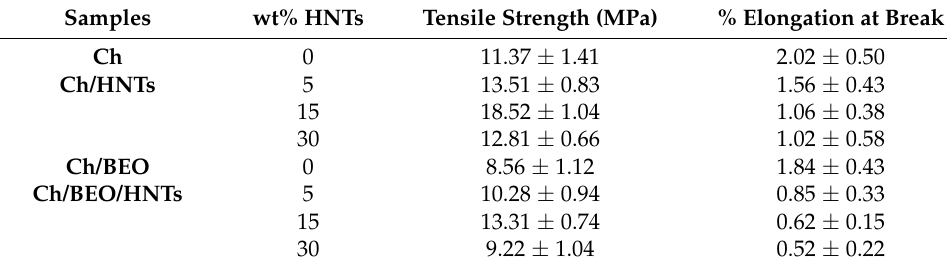
Table 2. Tensile strength and elongation at break of the films.